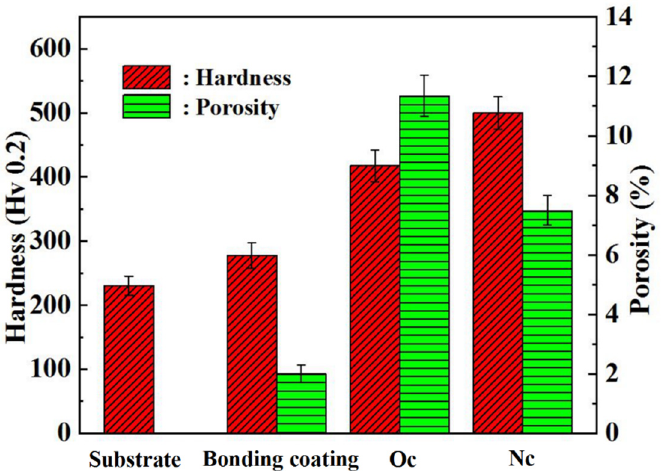
Figure 10. Hardnesses and porosities of the substrate, bonding coating and as-sprayed